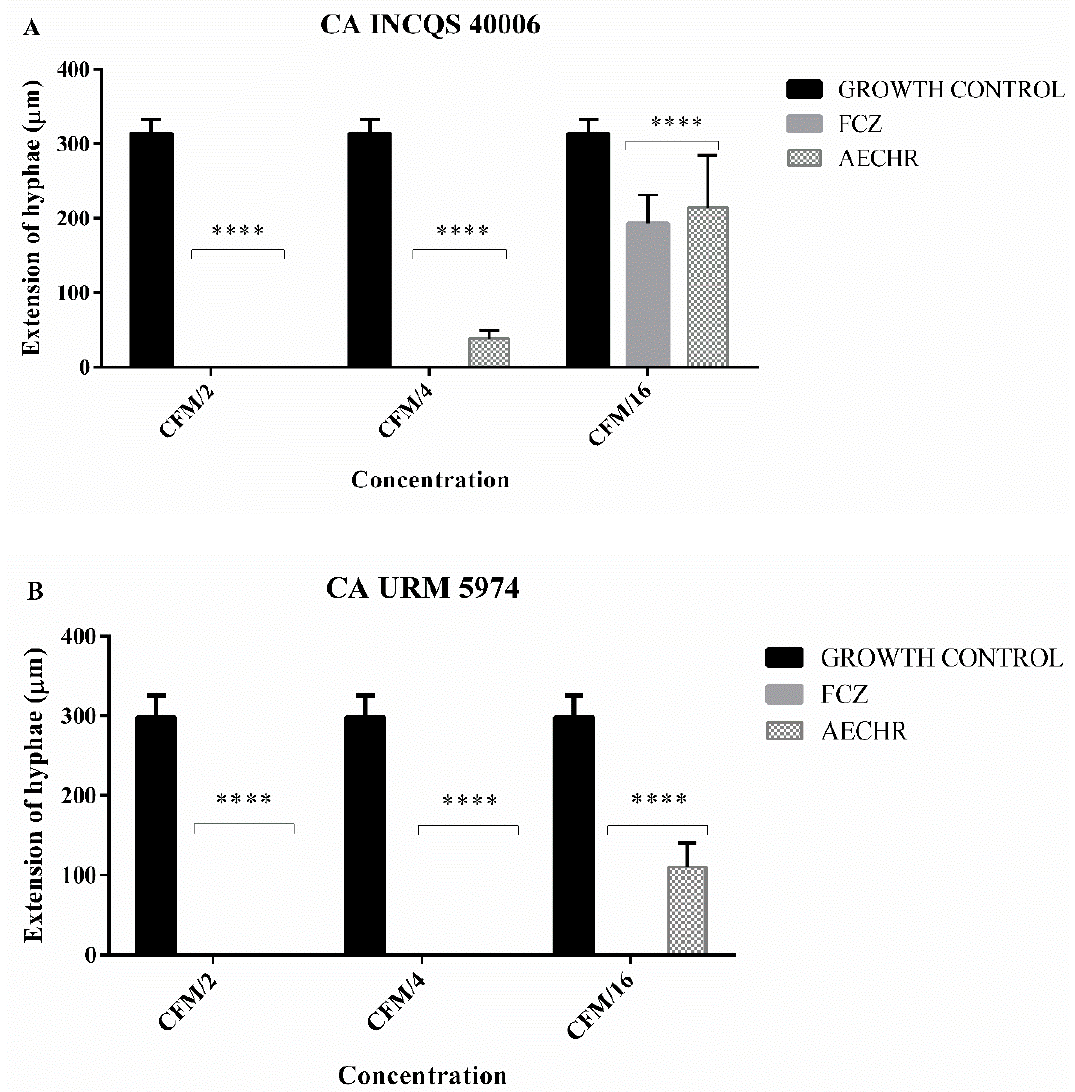
Figure 5. Effects of Croton heliotropiifolius extract on the morphological transition of C. albicans . The absence of bars occurs due to complete inhibition of filamentous structures. The extract and fluconazole inhibited the morphological transition at some concentrations. A —**** = p < 0.0001; B — **** = p < 0.0001. Table 4. Antiparasitic and cytotoxic effects of the Croton heliotropiifolius